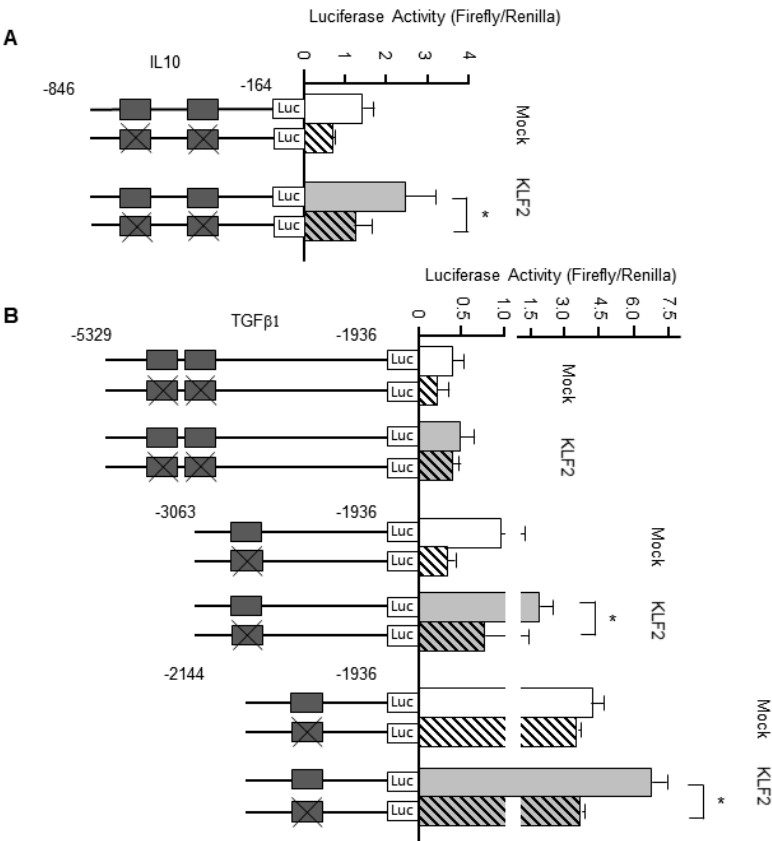
Figure 5. Effects of Krüppel-like factor-2 (KLF2) overexpression on genes encoding anti-inflammatory cytokines. HEK293T cells were co-transfected with the indicated luciferase reporter for interleukin (IL)-10 or transforming growth factor beta-1 (TGF β 1) expression and either a KLF2 overexpression plasmid (KLF2 columns) or empty vector (mock columns). Luciferase activity was normalized to Renilla luciferase activity. ( A ) Averaged data for luciferase activity in experiments using the luciferase reporter for IL-10. * p < 0.05 vs. IL-10 promoter with KLF2 overexpression plasmid. ( B ) Averaged data for luciferase activity in experiments using the luciferase reporter for TGF β 1. * p < 0.05 vs. TGF β 1 promoter with KLF2 overexpression plasmid.